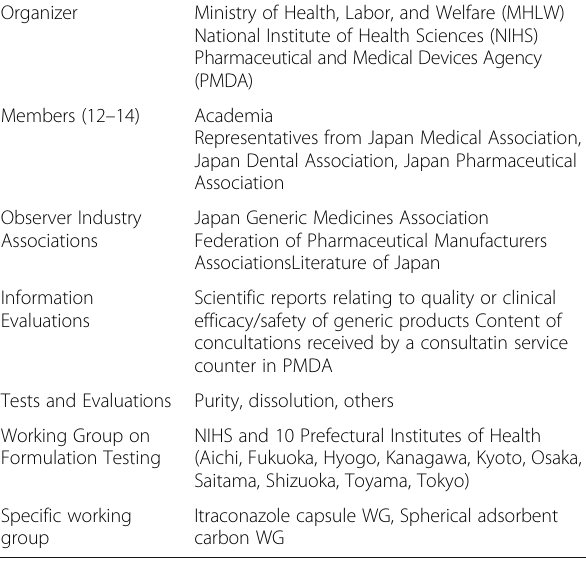
Table 2 Expert Committee on Quality of Generic Drug